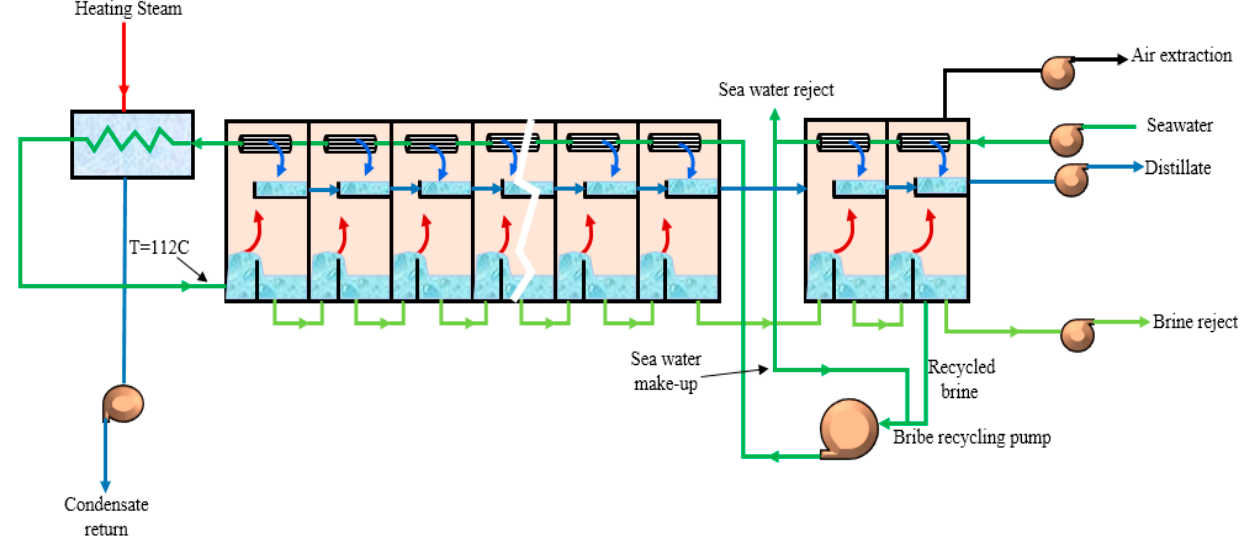
Figure 2. A schematic diagram of MSF seawater desalination plant.